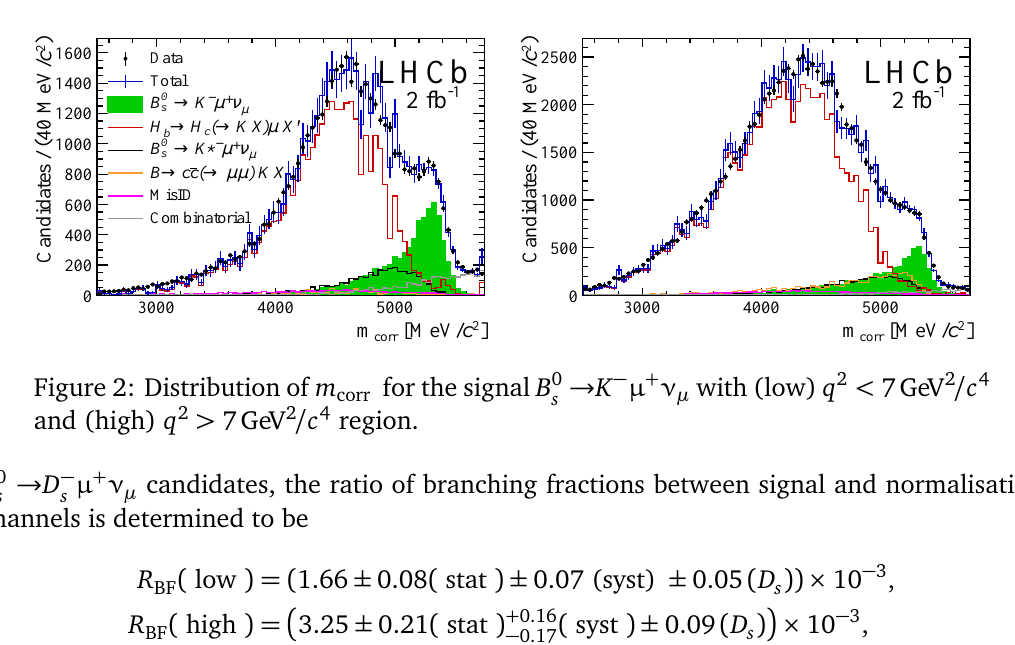
Figure 2: Distribution of m and (high) q 2 > 7GeV 2 / c 4